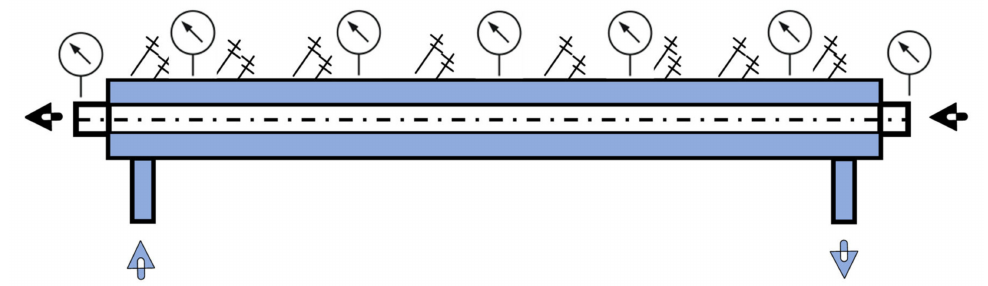
Figure 2. View of the channels for heat-transfer testing during refrigerant condensation in pipe minichannels with pressure and temperature sensors installed.